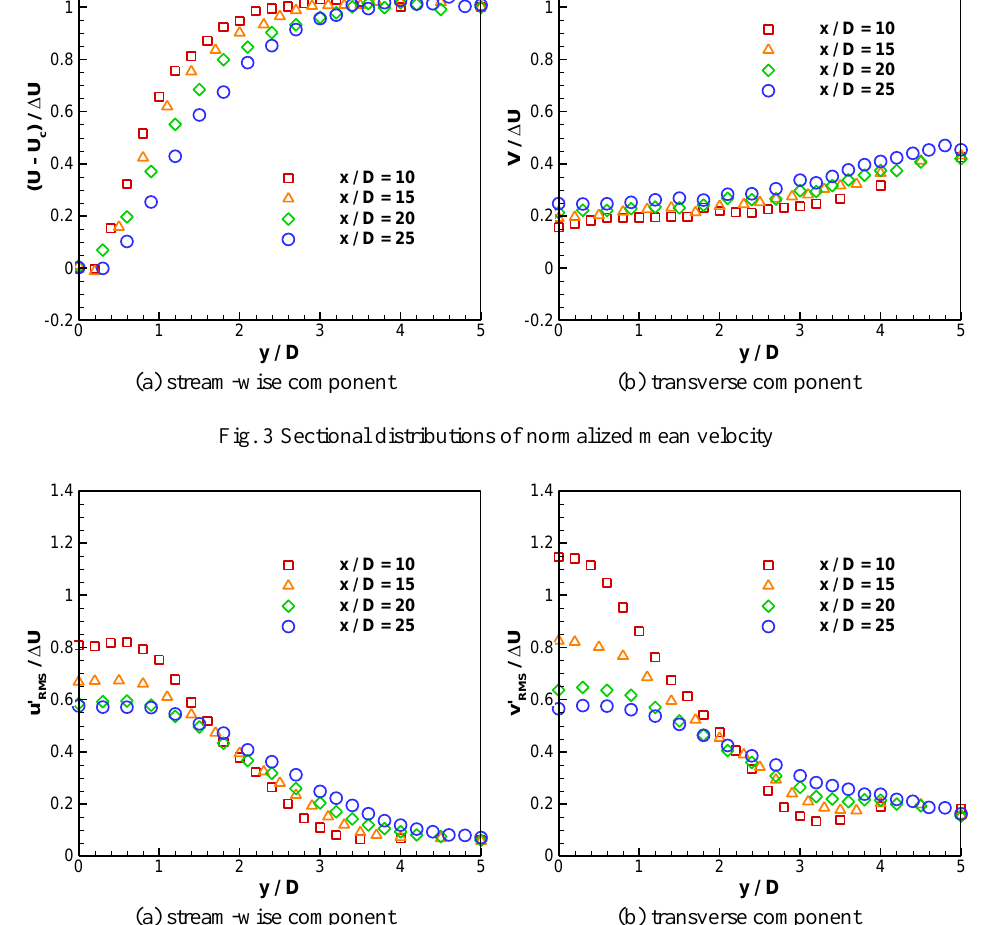
Fig. 4 Sectional distributions of normalized root-mean-square fluctuating